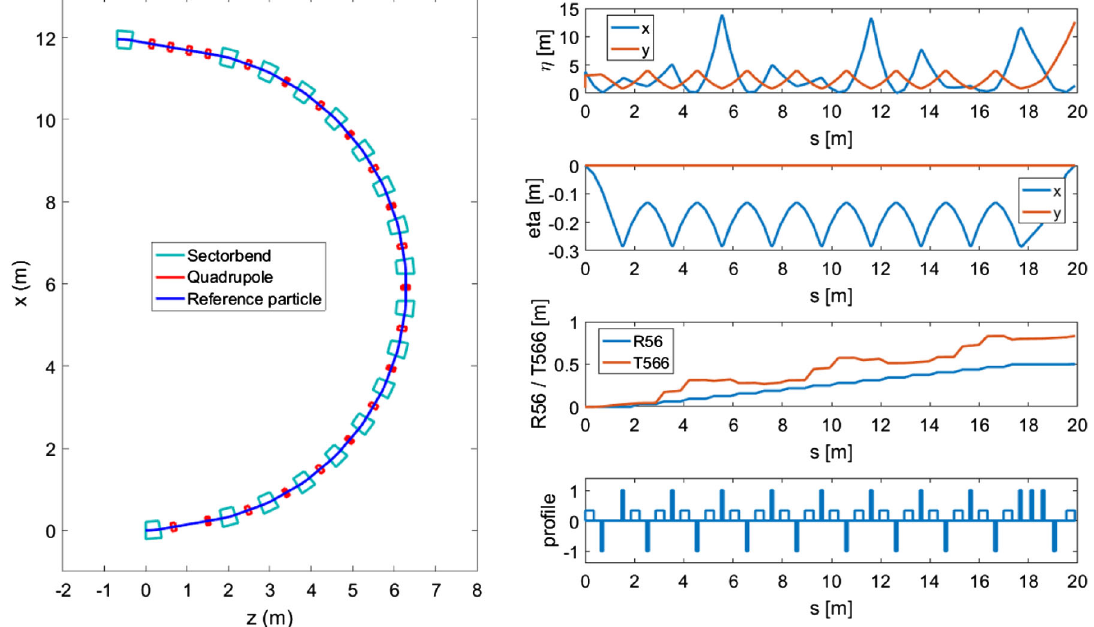
FIG. 2. Plan view of the FODO-arc lattice (left) and optics functions along it (from top to bottom, betatron functions, dispersion functions, first and second order transport matrix coefficients, magnetic